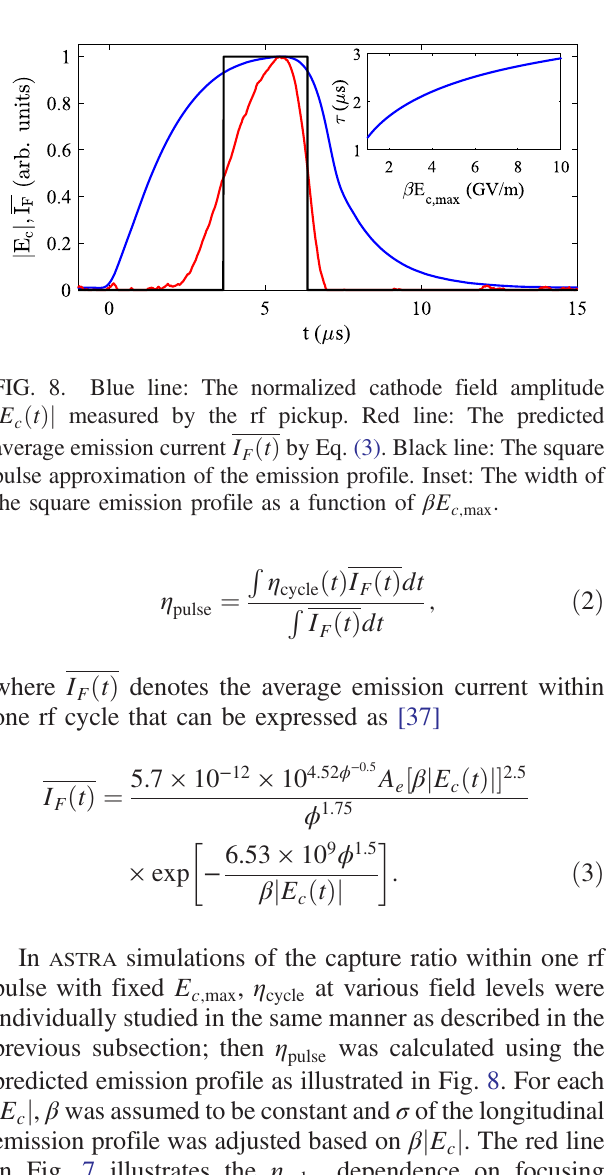
FIG. 7. The capture ratio of the Faraday cup with β of 179. Blue line: η with j E c j of 42 MV = m; red line: η cycle 42 MV = m; black line: measured charge at E with the maximum value normalized to the highest capture ratio in the simulation.